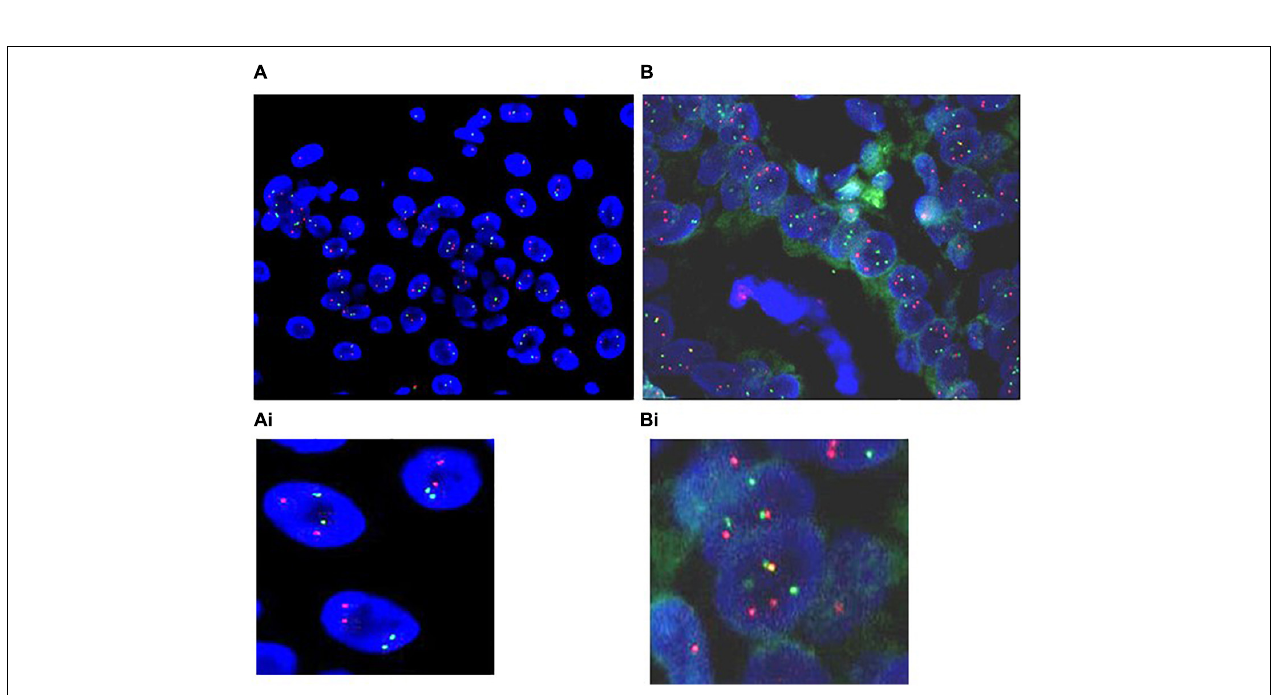
FIGURE 3 | Translocations occur in human EAC and not in paired normal esophageal epithelium and non-dysplastic BE. Representative pictures of (A) . The non-dysplastic BE tissue: two signals in red and green representing two (Chr2 and Chr16) normal homologous chromosome pairs. (Ai) Enlargement of the normal signal. (B) FISH signal from paraffin-embedded EAC tumor tissue using BAC-FISH probes for Chr2p22 (red) and Chr16q22 (green) breakpoints, showing a fusion (yellow). The red and green signals denote intact parent chromosomes, and the yellow signal marks the fusion of the two chromosomes. Some cells also have three or more signals of each color representing breakage of chromosomes but no fusion. (Bi) Enlarged view of the FISH signals in tumor tissue.